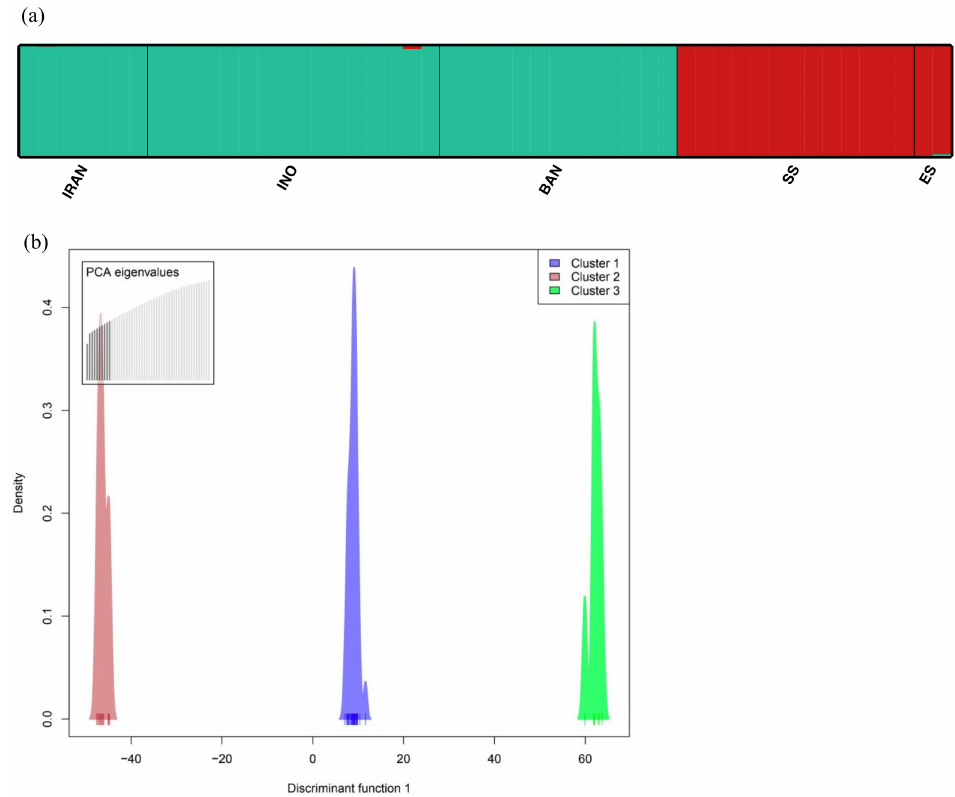
Figure 3. Cluster groupings based on SNP data for Pampus cinereus . ( a ) Two clustering groups ( K = 2) were suggested by STRUCTRUE analysis based on the highest delta K value. IRAN denotes the Arabian Sea population, INO the Indian Ocean population, BAN the Bay of Bengal population, SS the South China Sea population and ES the East China Sea population. ( b ) Three clusters represented by a single discriminant function in the DAPC analysis, cluster 1 including individuals sampled from INO and BAN, cluster 2 including individuals sampled from SS and ES and cluster 3 including individuals sampled from